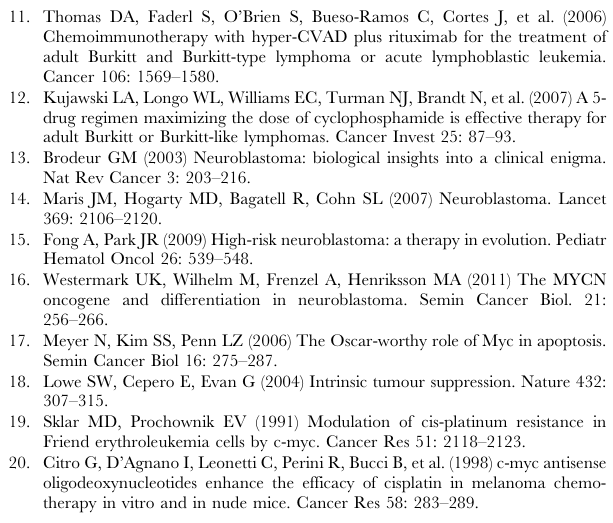
Figure S2 Concentration response curves for IC50 calculations. (A) Concentration-response curves for p493-6 cells treated with the indicated drugs in the presence (c-MYC OFF) or absence (c-MYC ON) of doxycycline for 48 h. The